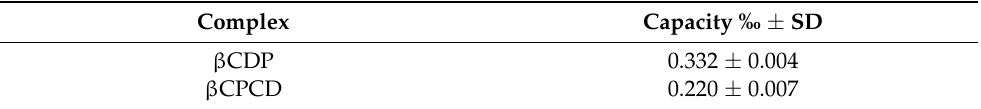
Table 1. Curcumin loading capacities of β CDP and β CPCD in water (data are presented as means ± SD; n = 3).